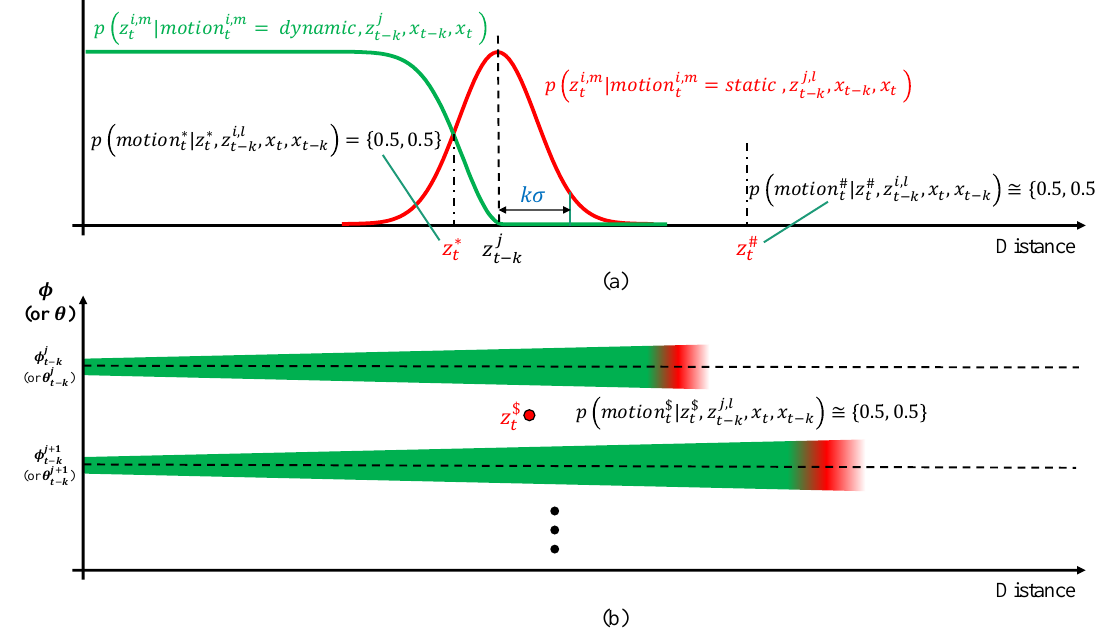
Figure 8. Problems of probabilistic motion segmentation. The probabilities of motion for z # ( b ) are close to { 0.5,0.5 } , because both likelihoods for dynamic and static are